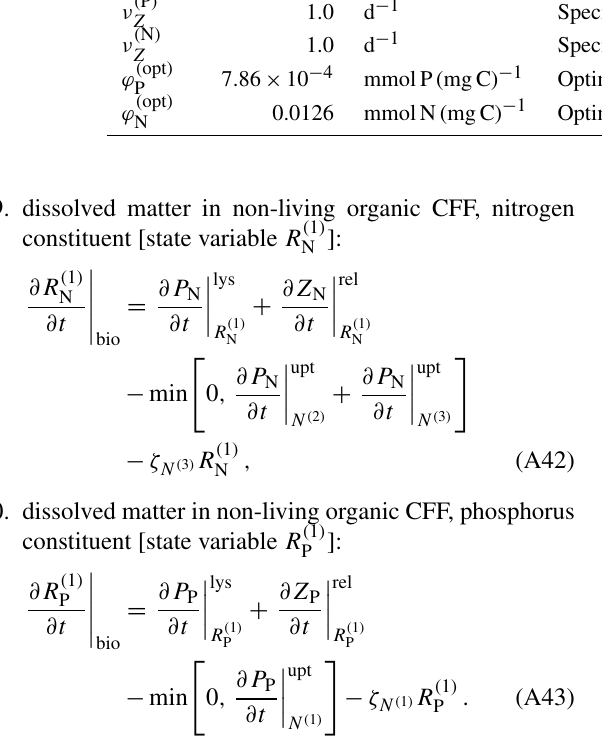
Table A4. Zooplankton parameters, values, units, and descriptions within the BFM17 pelagic model. Symbol Value Unit Description h ( O ) 0.5 mmolO 2 m − 3 Half saturation for zooplankton processes Z µ Z 50.0 mgCm − 3 Feeding threshold b Z 0.02 d − 1 Basal specific respiration rate r ( 0 ) 2.00 d − 1 Potential specific growth rate Z 0.25 Oxygen-dependent specific mortality rate 0.50 0.25 0.72